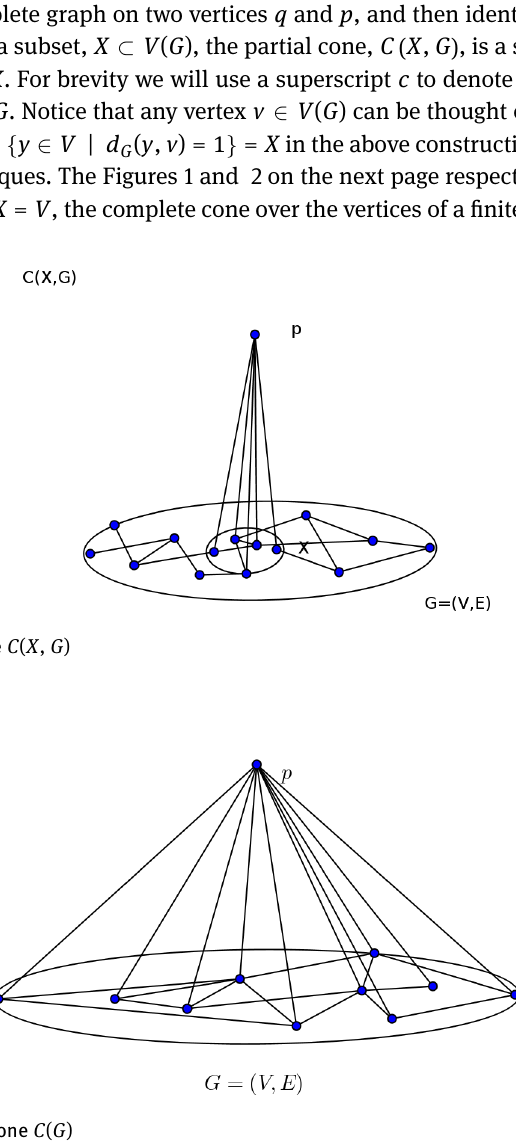
Figure 2: Example of a complete cone C ( G